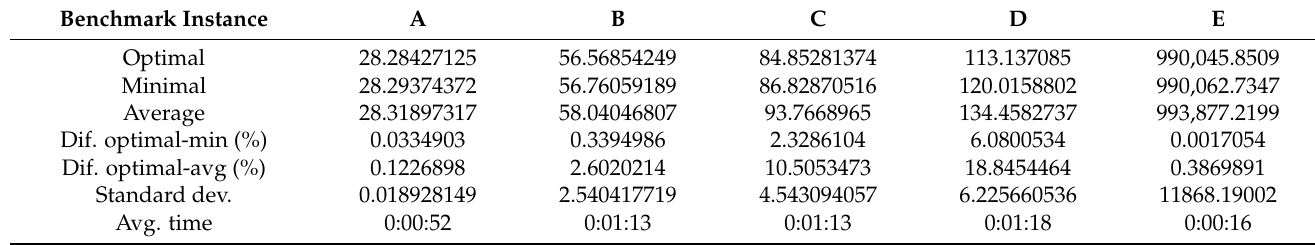
Table 6. Calculations